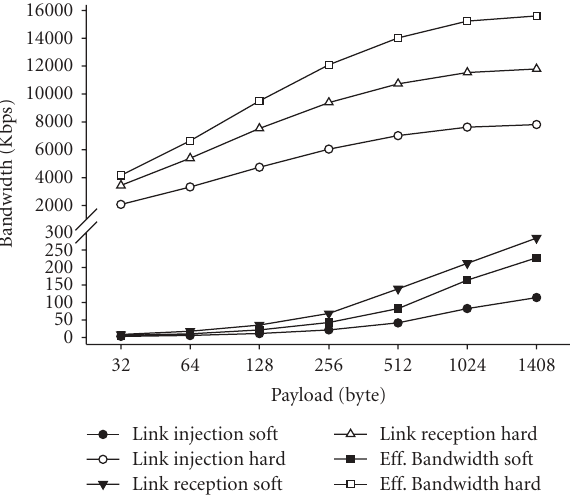
Figure 14: Comparison of latencies between software and hardware